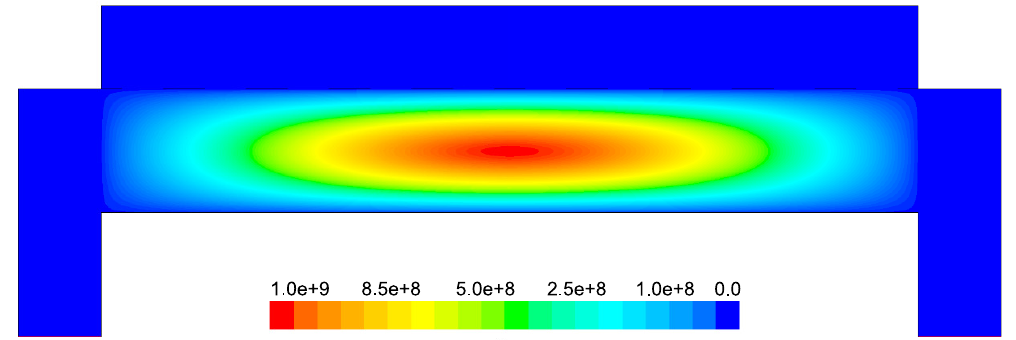
Figure 6. Electron density within 2D axisymmetric PECVD geometry (cm − 3